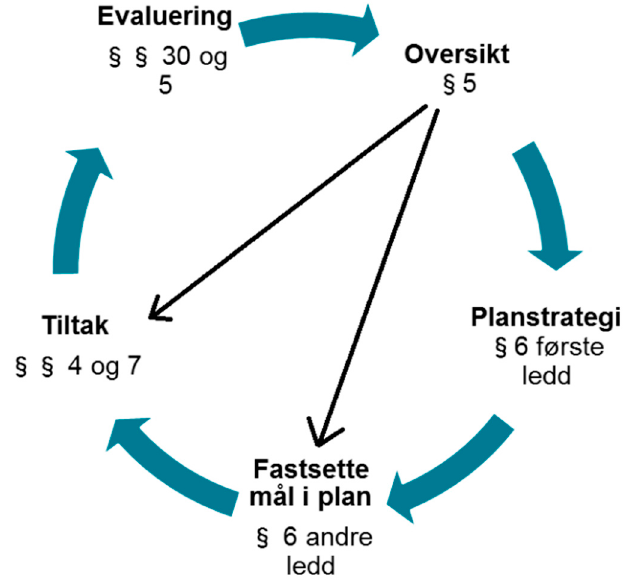
Figure 1. Illustration of the systematic public health work, Reprinted with permission from [7] (Norwegian Directorate of Health, 2018) [Translation to English: § 5 Overview (Oversikt), § 6 1st Paragraph Planning strategy (Planstrategi), § 6, 2nd paragraph Determine goals in plans (Fastsette mål i plan), §§ 4 and 7 Measures/Action (Tiltak), §§ 30 and 5 Evaluation (Evaluering)].